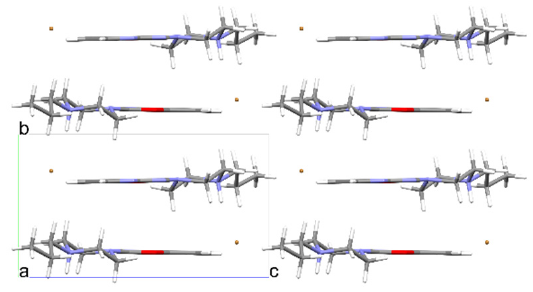
Figure 19. The crystal packing of 7 .